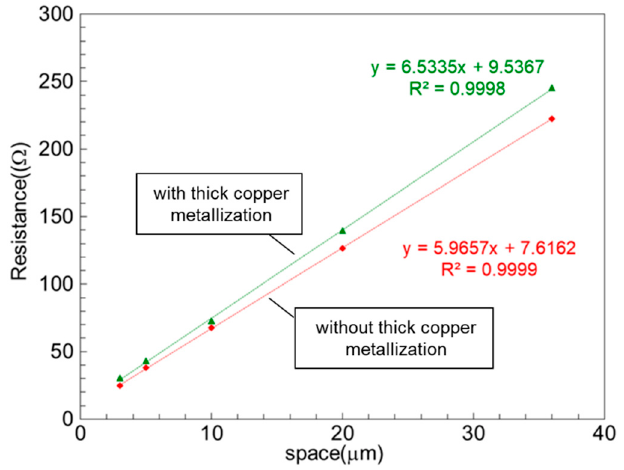
Figure 4. Transmission line method (TLM) measurement results before and after thick copper metallization.